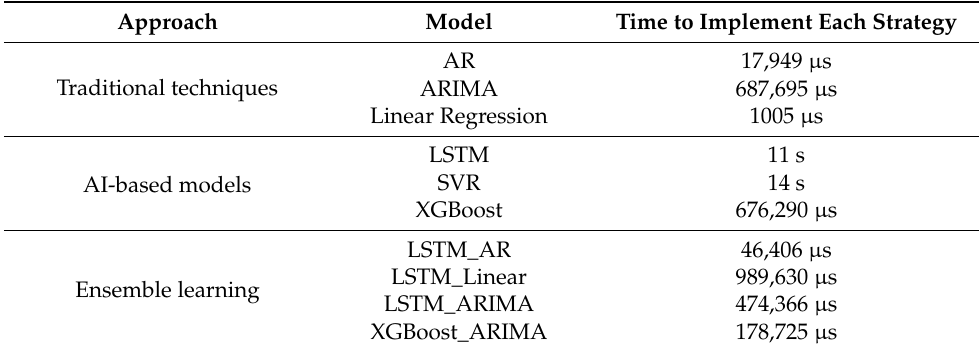
Table 3. Running time required for implementing each approach.